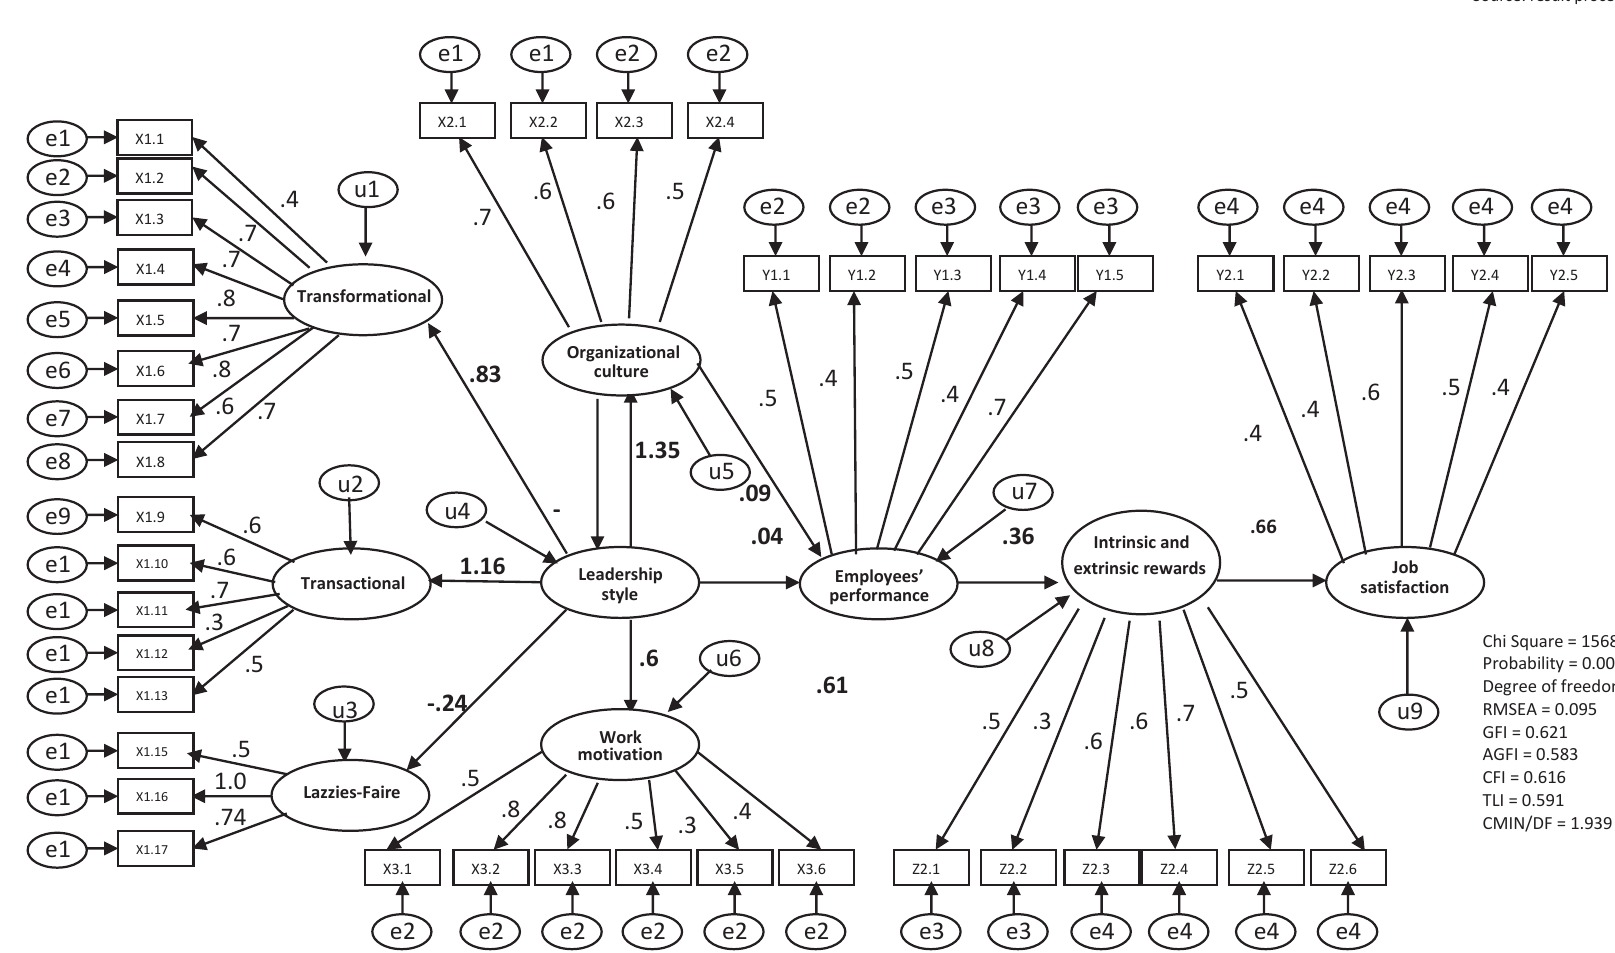
Figure 2. The results of early test of the relation between variables and male middle